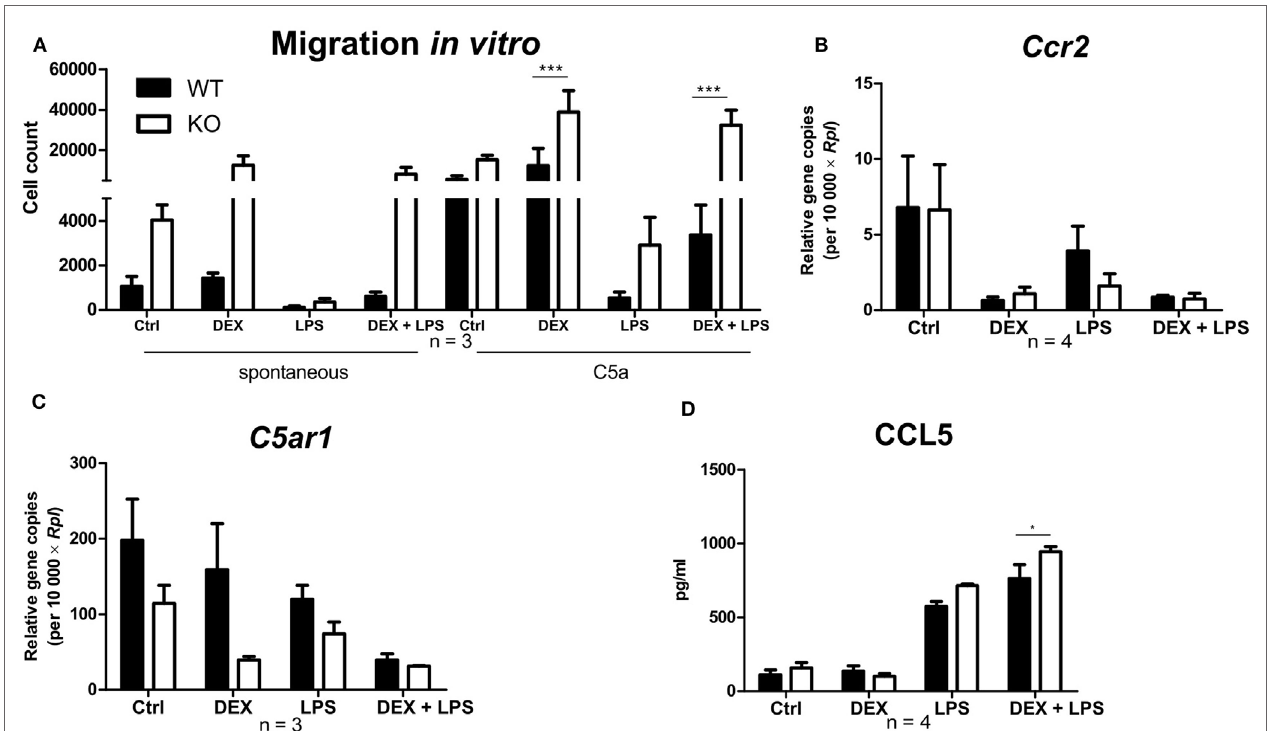
FigUre 7 | Deletion of peroxisome proliferator-activated receptor- γ promotes a dexamethasone (DEX)-induced increase in migration in vitro . (a–D) After 5 days of differentiation, ER-Hoxb8 macrophages were stimulated with DEX (100 nM) and/or LPS (1 µg/ml) for 24 h (B,c) or 48 h (a,D) . (a) Spontaneous migration and chemotaxis toward C5a were determined using transwell filters. (B,c) Gene expression of the indicated genes was analyzed using qPCR. (D) CCL5 secretion to the culture supernatants was determined using CBA. (a–D) The bars represent the mean with the SEM of three to four independent experiments (* p < 0.05, *** p < 0.001) (calculated by using two-way